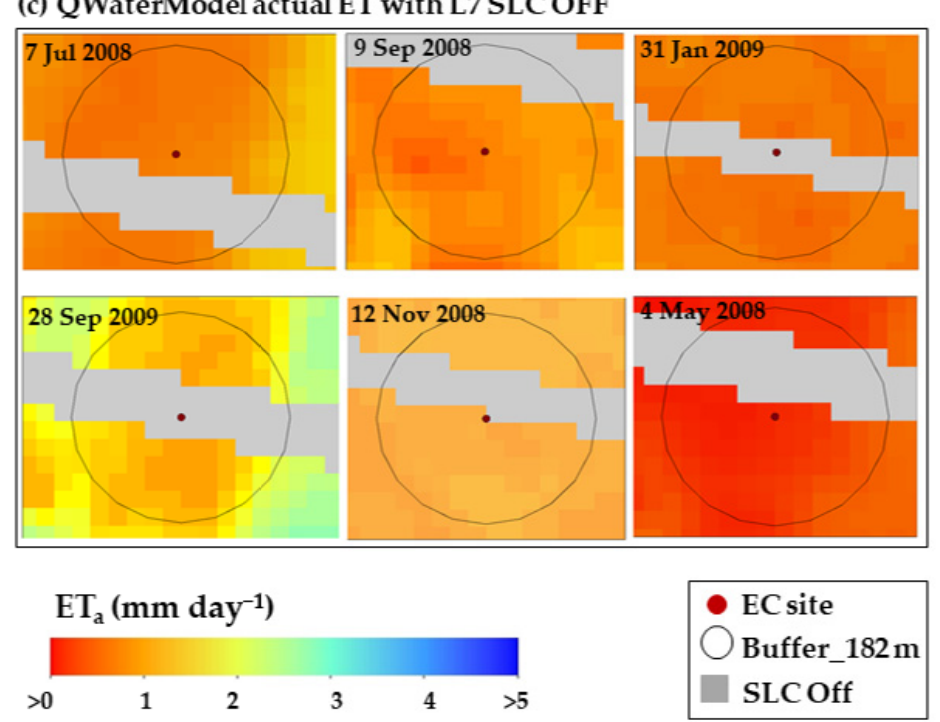
Figure 8. Maps present the Landsat 7 images showing no-data over the field location due to scan line corrector (SLC) failure, except for the SEBS, where gap-filled protocol was applied before simulations in SEBS. Different panels also highlight the spatial differences among ET a estimates by ( a ) SEBS, ( b ) METRIC-EEFlux, and ( c ) QWaterModel in the spatial ET